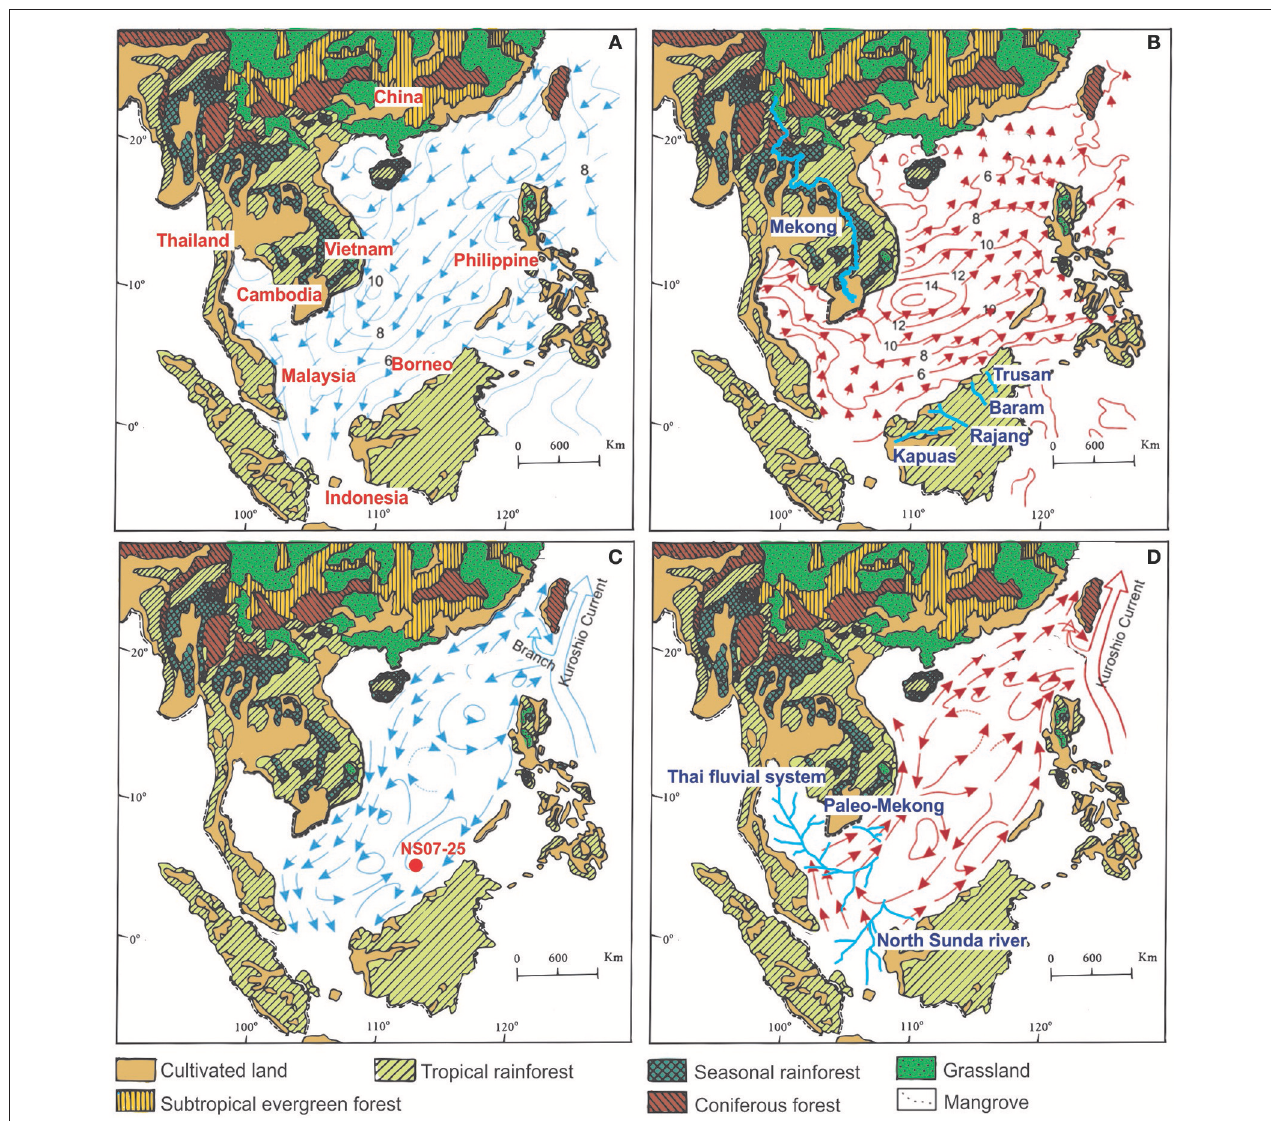
FIGURE 2 | Maps showing major regional vegetation types (Sun and Li, 1999). Surface winds over the SCS with wind velocity in (A) winter (December–February) and in (B) Surface winds over the SCS with wind velocity in summer (June–August) (from Wang et al., 2009) and (B) modern river system (light blue); Surface circulation of the modern SCSin (C) winter and Surface circulation of the modern SCS in (D) summer (from Fang et al., 1998) with (D) paleo-river system (light blue) (Voris, 2000) Modified after (Li et al.,